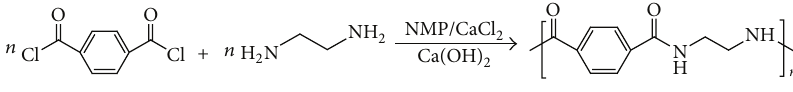
Scheme 1: The synthesis of PETA.